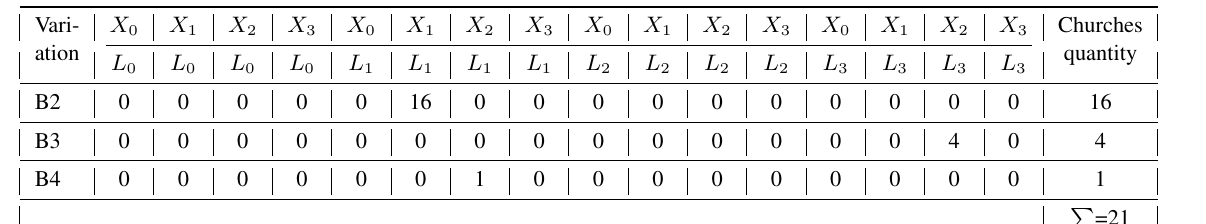
Table 6: Remaining numbers in the cases 2 to 4.